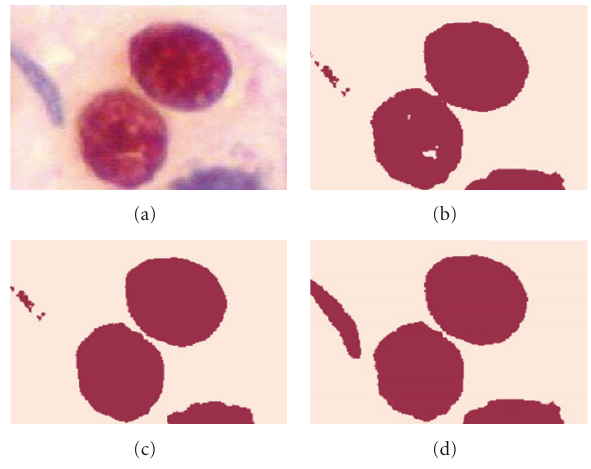
Figure 6: Comparison of the proposed segmentation method with other existing methods on a complex medical image (2 classes, various cells). (a) Original image (256 × 256 × 3): colour medical image with RGB description, (b) segmentation based on HCM and DS, (c) segmentation based on FCM and DS, and (d) segmentation based on homogeneity and DS.